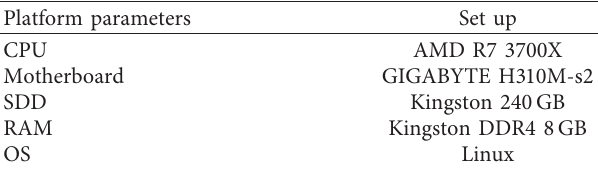
Table 2: Test data for music signal detection. Number of samples without Number of samples Number noise